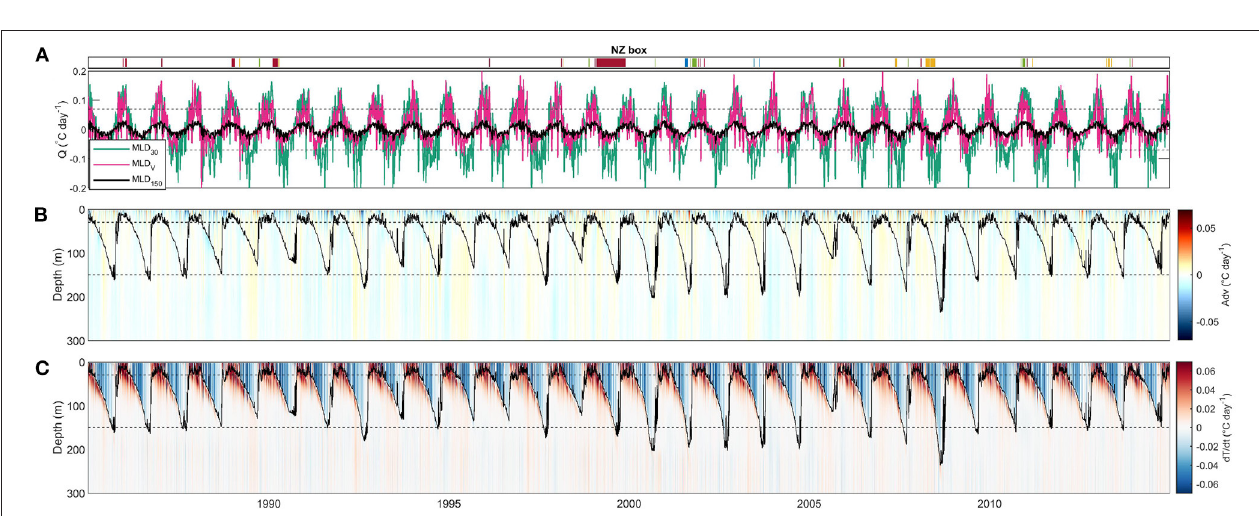
FIGURE 9 | Eddy box time-series (1985–2014) showing the air-sea heatflux term (A) as calculated using the three SML scenarios: MLD 30 (green), MLD V (red), and MLD 150 (black). Hovmoller plots shows advection contribution (B) and temporal change of temperature (C) with depth. MLD V is shown with a solid black line, MLD 30 and MLD 150 are marked by dashed lines. MHWs are marked with rectangles in the top bar with colors corresponding to the season in which an event began: summer (DJF) = red, autumn (MAM) = yellow, winter (JJA) = blue, spring (SON) = green.